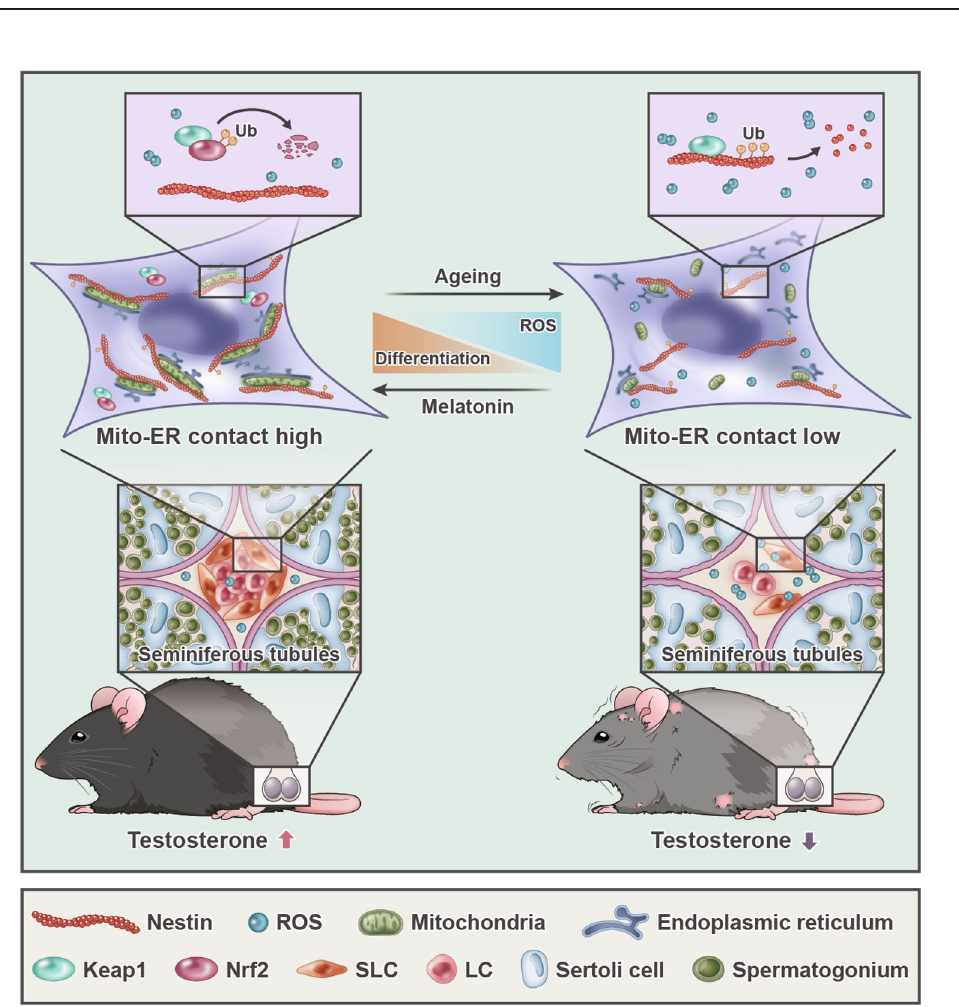
Fig. 8 Schematic illustration of Nestin-mediated MERCs loss during reproductive ageing and melatonin ’ s anti-senescence effect. Loss of intermediate fi lament Nestin compromises the differentiation capacity of SLCs via separating MERCs during senescence. Pharmacological intervention by melatonin restores Nestin-dependent MERCs, improving SLC differentiation capacity and alleviating male reproductive system